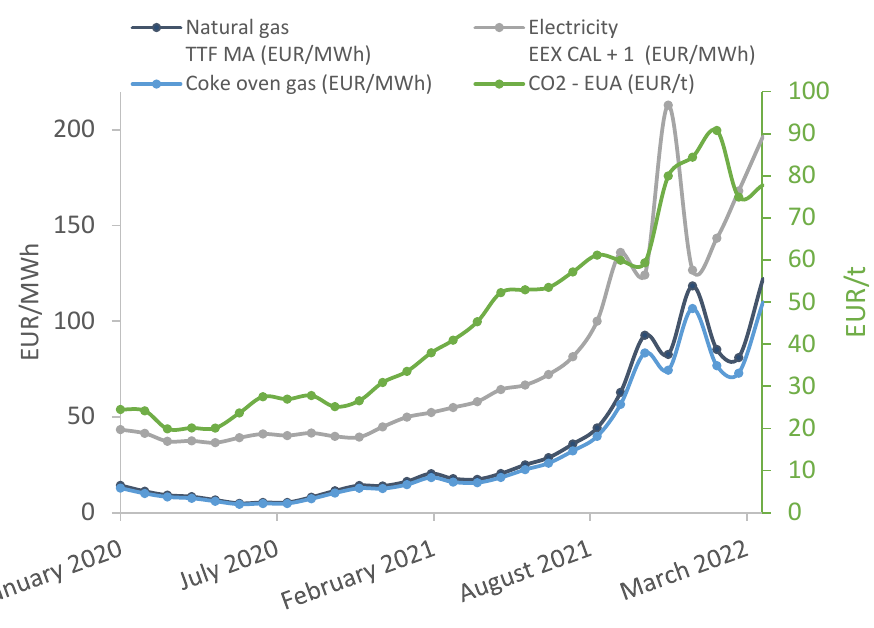
Figure 1. Prices of energy commodities 2020 – 2022 [3].